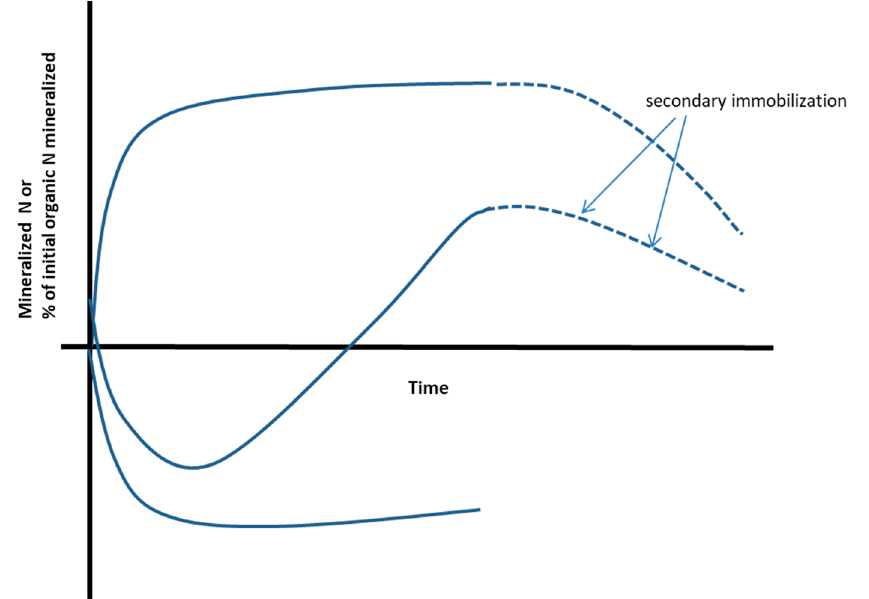
Figure 3. Alternative dynamics of soil inorganic N after the addition of organic residues illustrating secondary immobilization.